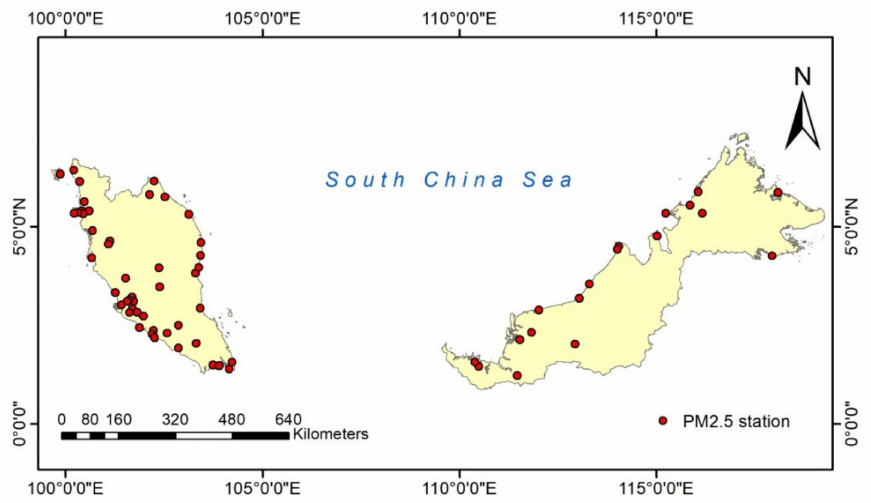
Figure 1. Locations of the 65 air quality monitoring stations across